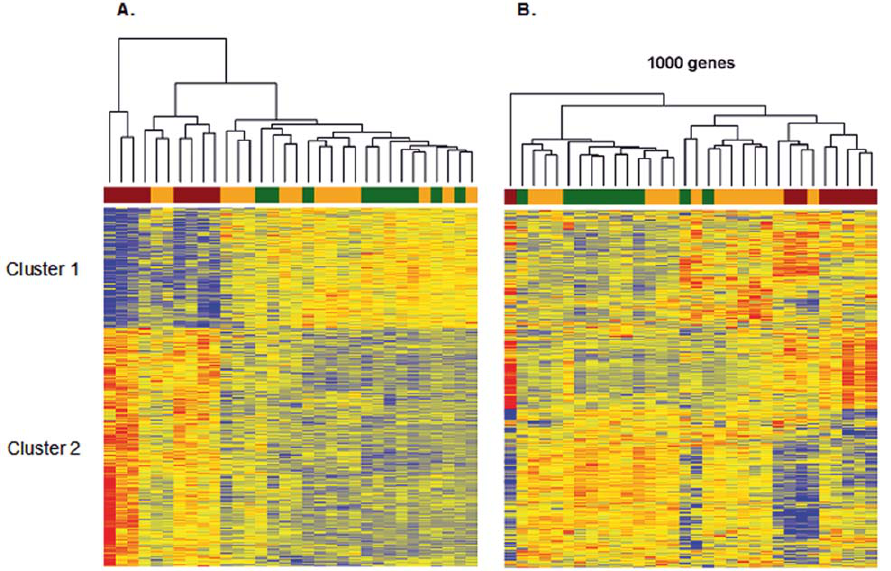
Figure 1. Supervised (A) and unsupervised (B) clustering of differentially expressed genes in the three groups of liver samples. A. Common differentially expressed genes were used for supervised clustering. B. Unsupervised clustering was performed with the 1000 most variable genes in the three groups of liver samples (steatohepatitis, red; steatosis, orange; controls, green). doi:10.1371/journal.pone.0046584.g001 PLOS ONE |